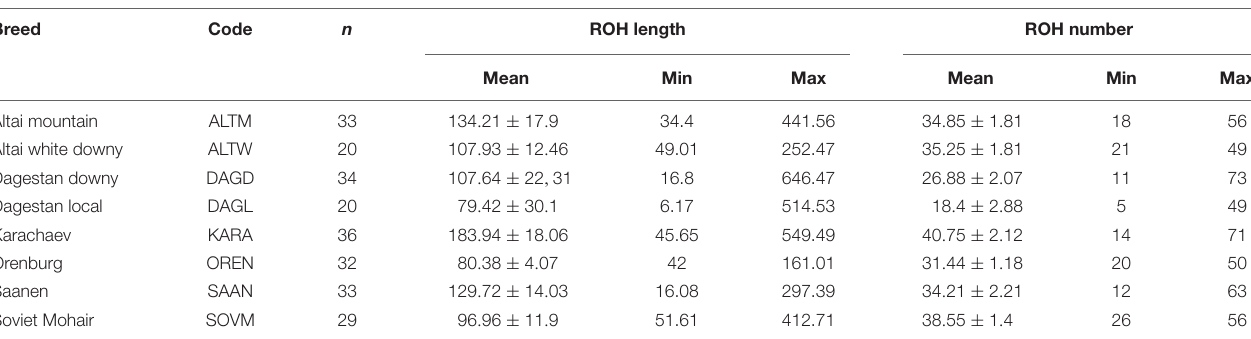
TABLE 3 | Mean ROH length and mean ROH number in Russian goat populations.